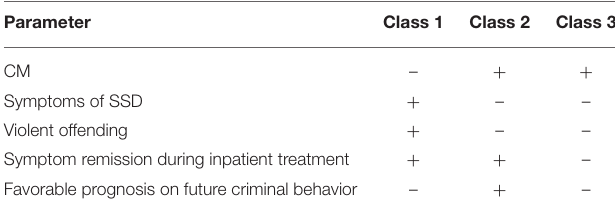
TABLE 4 | Overview of the most relevant results in the final